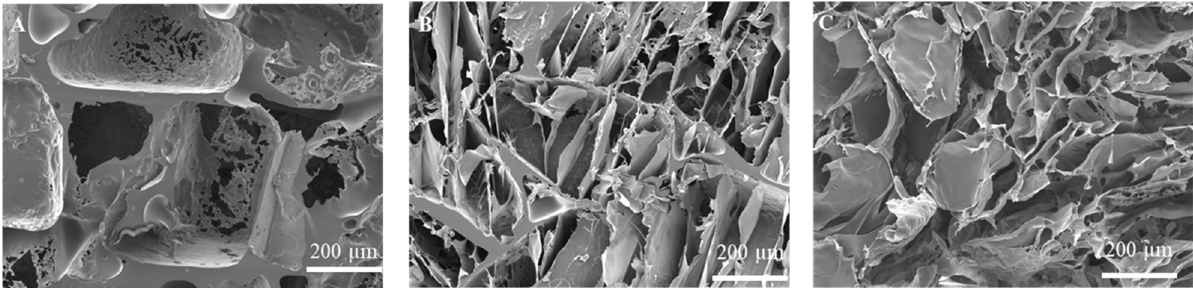
Figure 1. SEM images of cross-sections of ( A ) PLGA sponge, ( B ) PLGA-collagen sponge, and ( C ) collagen sponge.